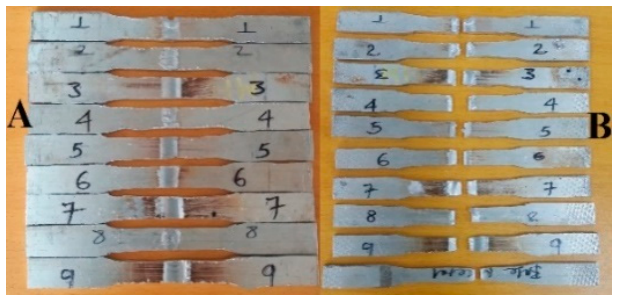
Figure 5. Extraction of tensile specimens: ( A ) Welded specimens before the tensile test; ( B ) welded specimens after the tensile test. Table 6. Control process parameters and their levels.